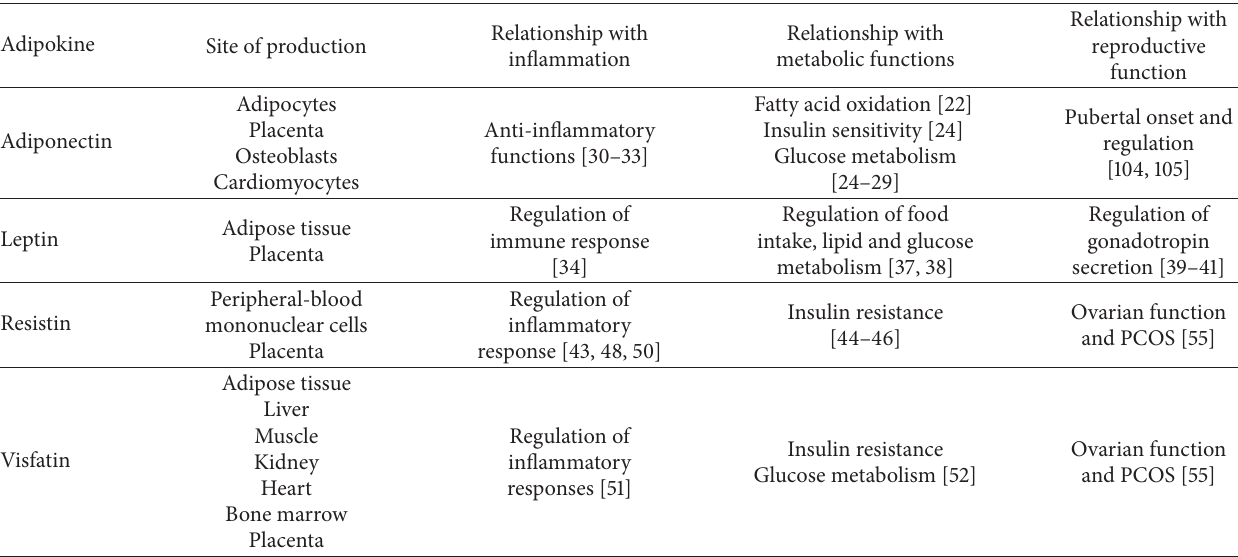
Table 1: Site of production and relationship of adipokines with inflammation and metabolic and reproductive function.